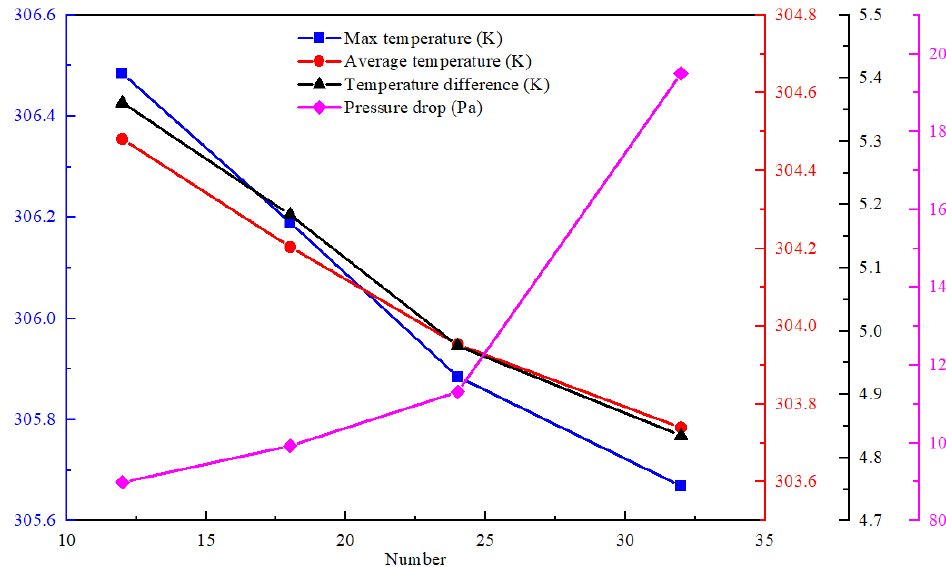
Figure 12. Influence of different pin-fin